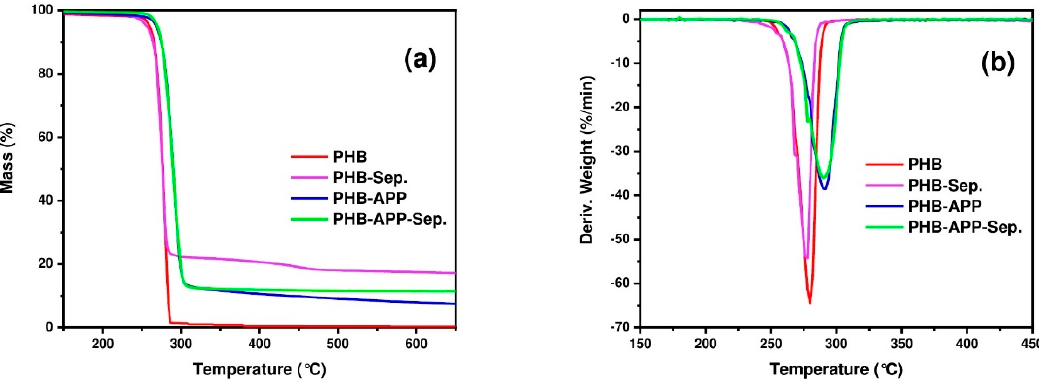
Figure 6. TGA thermograms of PHB and blends under nitrogen atmosphere. ( a ) TGA ( b ) DTG curves. Table 8. TGA parameters PHB and blends in nitrogen (*maximum weight loss temperature, obtained from DTG).